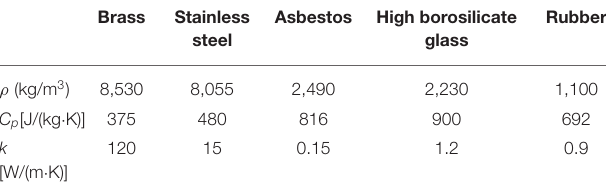
TABLE 2 | The thermo-physical properties of the solid materials.